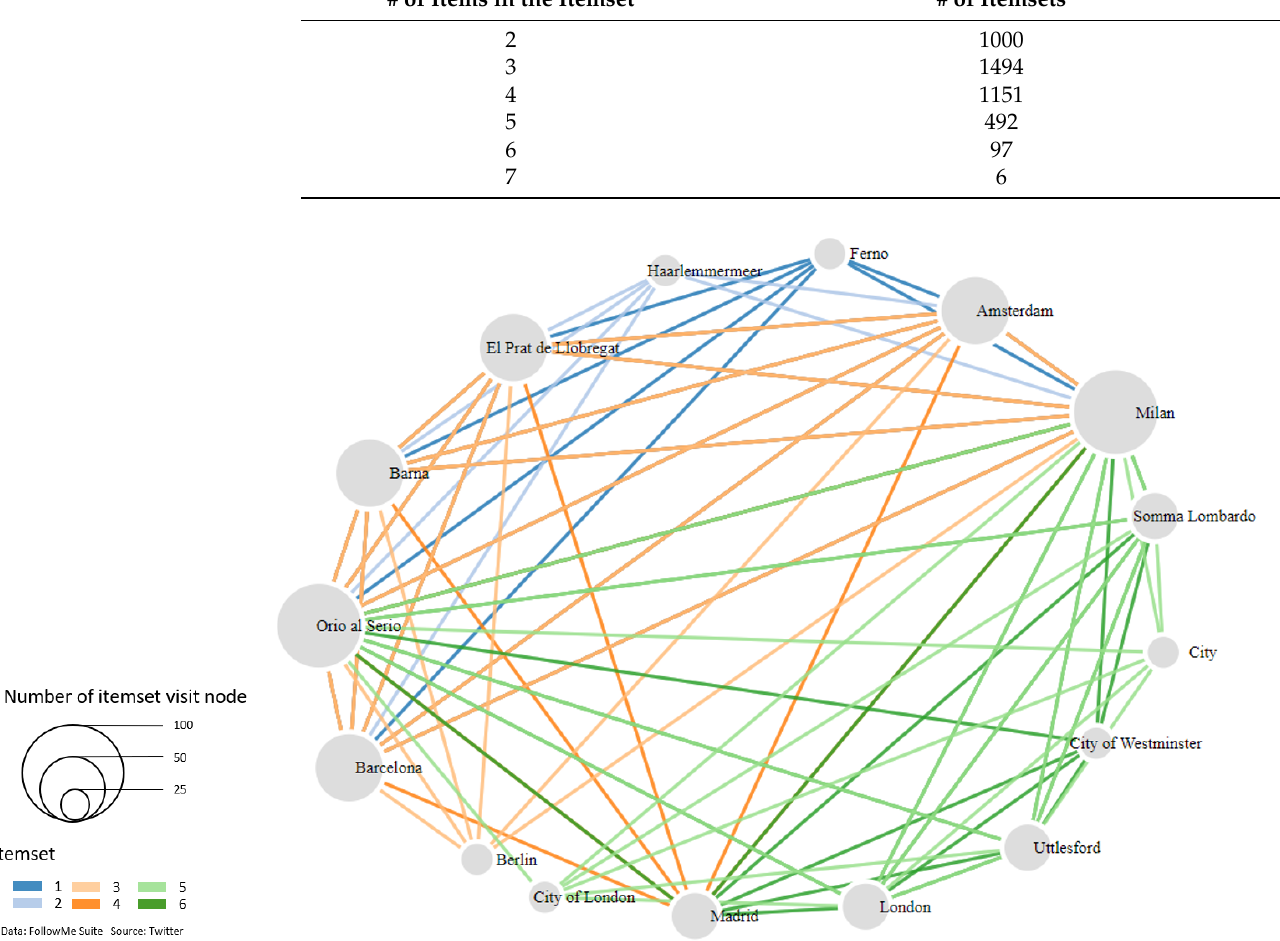
Figure 14. Topological representation for discovered itemsets from the large data set by applying Interpretation